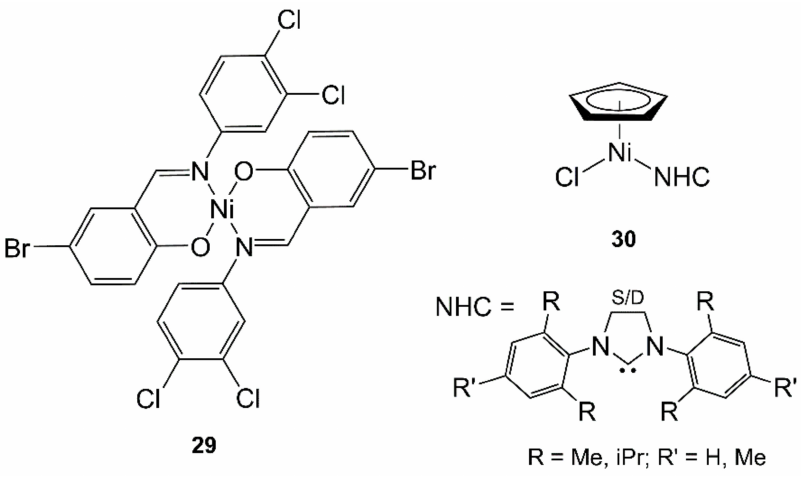
Figure 9. A selection of Ni complexes cited in the